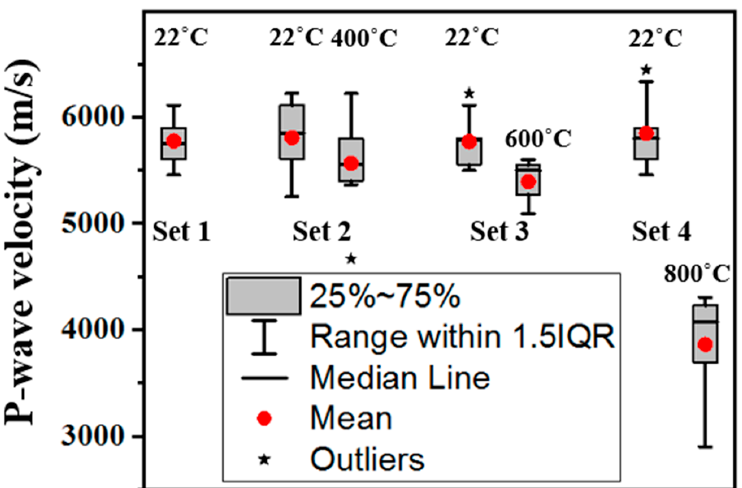
Figure 14. Results of the statistical analysis of P-wave velocities of the studied microschist samples.